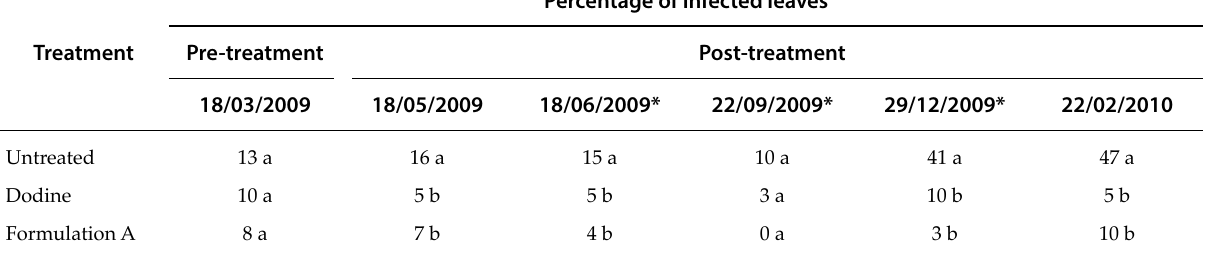
Table 2. Mean proportions of F. oleagineum infected leaves of the resistant olive cultivar Gentile di Chieti (G.C.). The data were arcsine-transformed before the analysis. Values with different letters are statistically different ( P <0.05) as determined by Fisher’s protected least significant difference (LSD).